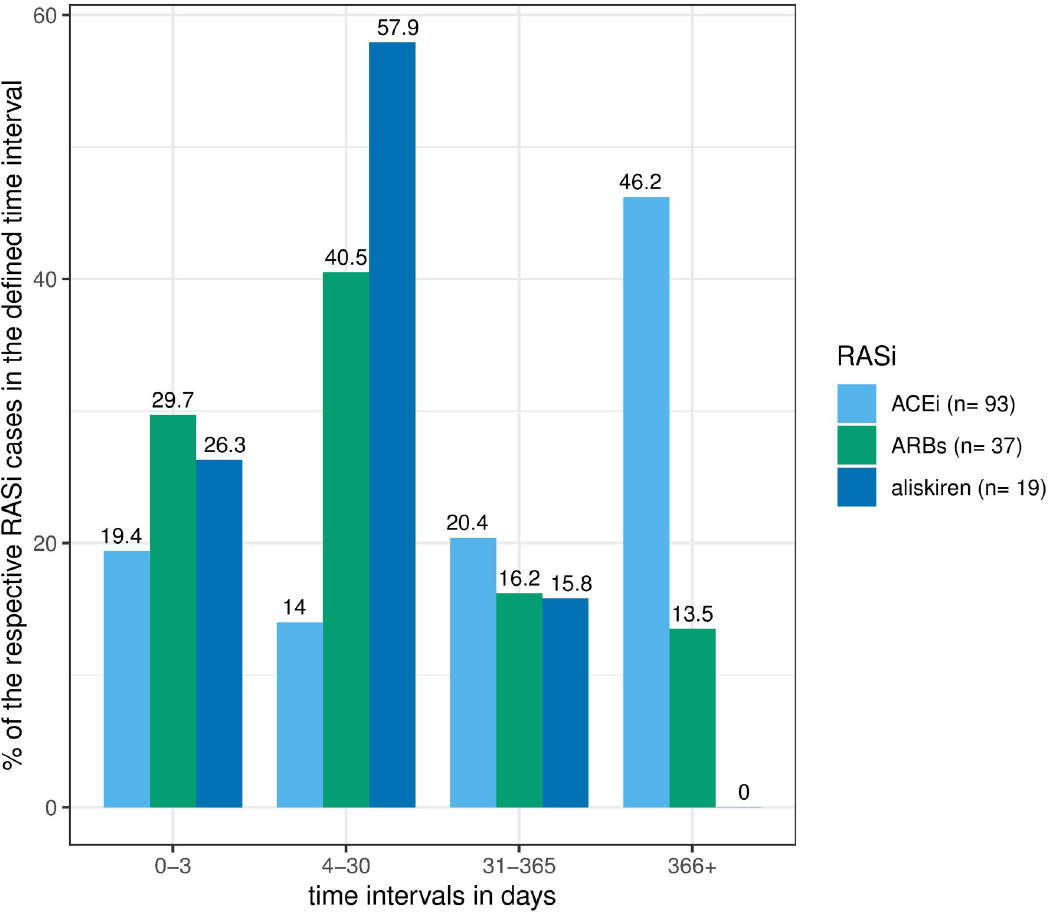
Fig 4. BfArM’s ADR-database analysis: "Time-to-onset" analysis of the angioedema reaction. Fig 4 shows the "time-to-onset" analysis of validated ACEi, ARBs, and aliskiren-associated angioedemas. In this figure only cases providing information on the "time-to-onset" were